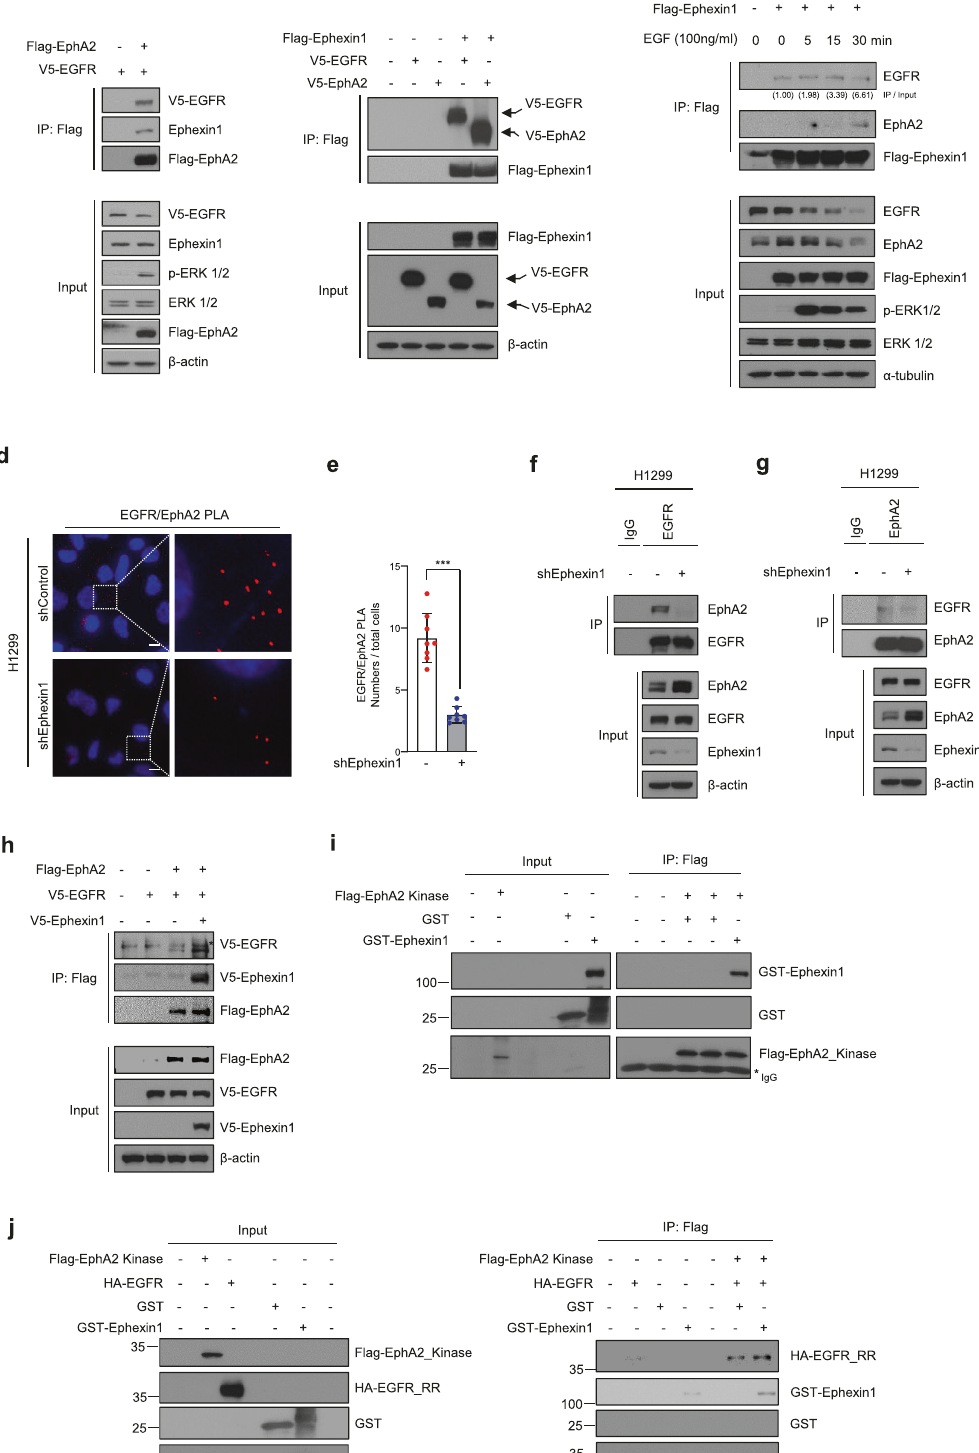
(Supplementary Fig. S1a). Similarly, for colorectal cancer patients, higher expression of Ephexin1 and EphA2 correlated to worse survival rates, and lower expression of EphA3 correlated to worse survival rates (Supplementary Fig. S1b, c). Therefore, we predicted that EphA1 or EphA2 were the most likely of the EphA receptor family members to be relevant to Ephexin1 and EGFR